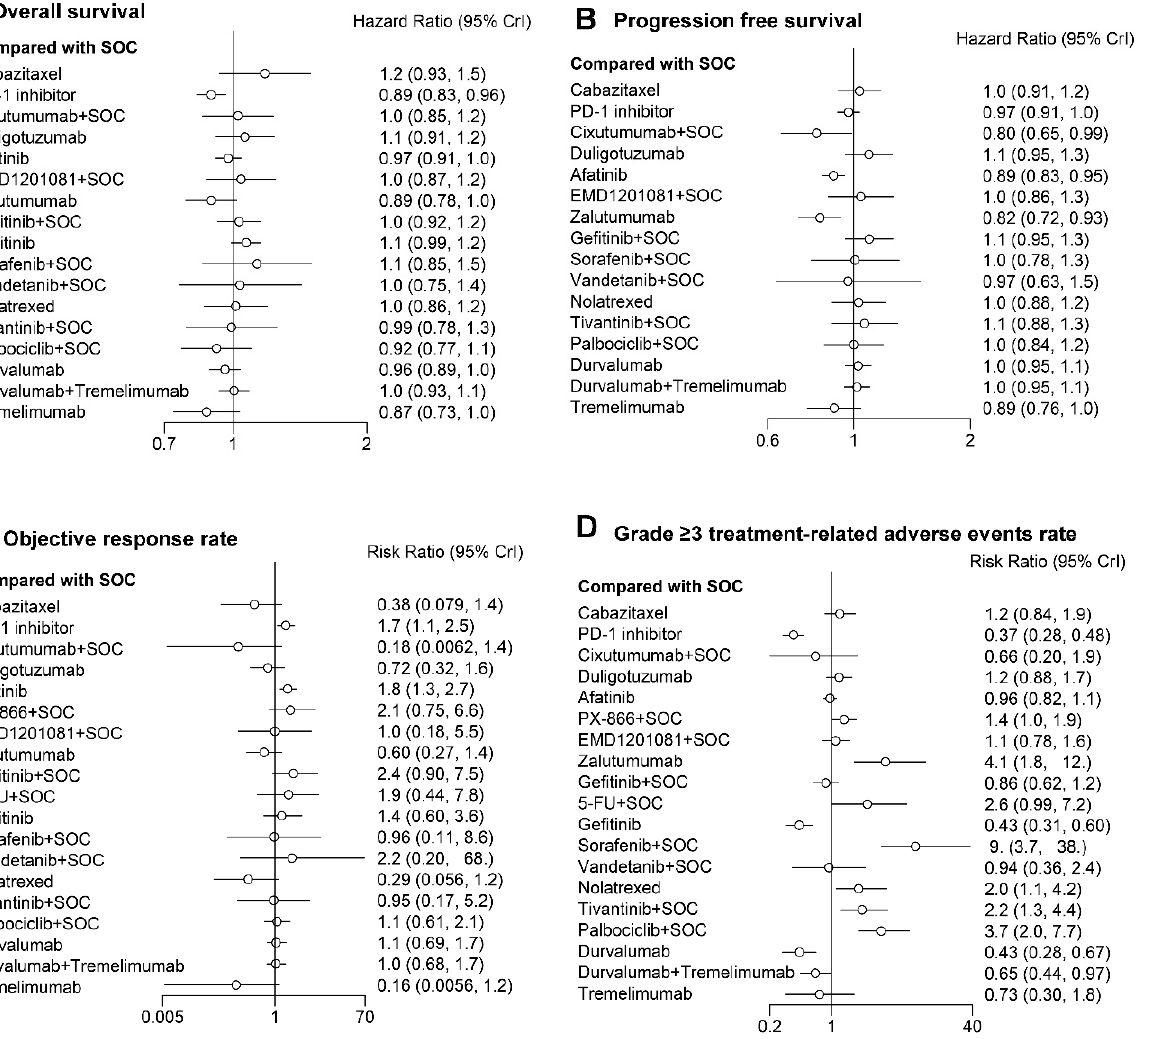
Figure 3. Forest plot of ( A ) overall survival (OS), ( B ) progression-free survival (PFS), ( C ) objective response rate (ORR), and ( D ) grade ≥ 3 treatment-related adverse events rates. SOC = standard of care (docetaxel, methotrexate, or cetuximab).